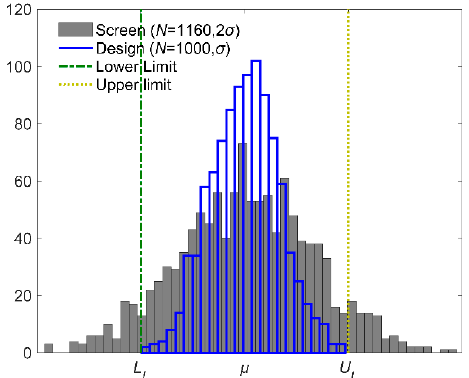
Figure 2. Quality distributions by screening and consistency design.